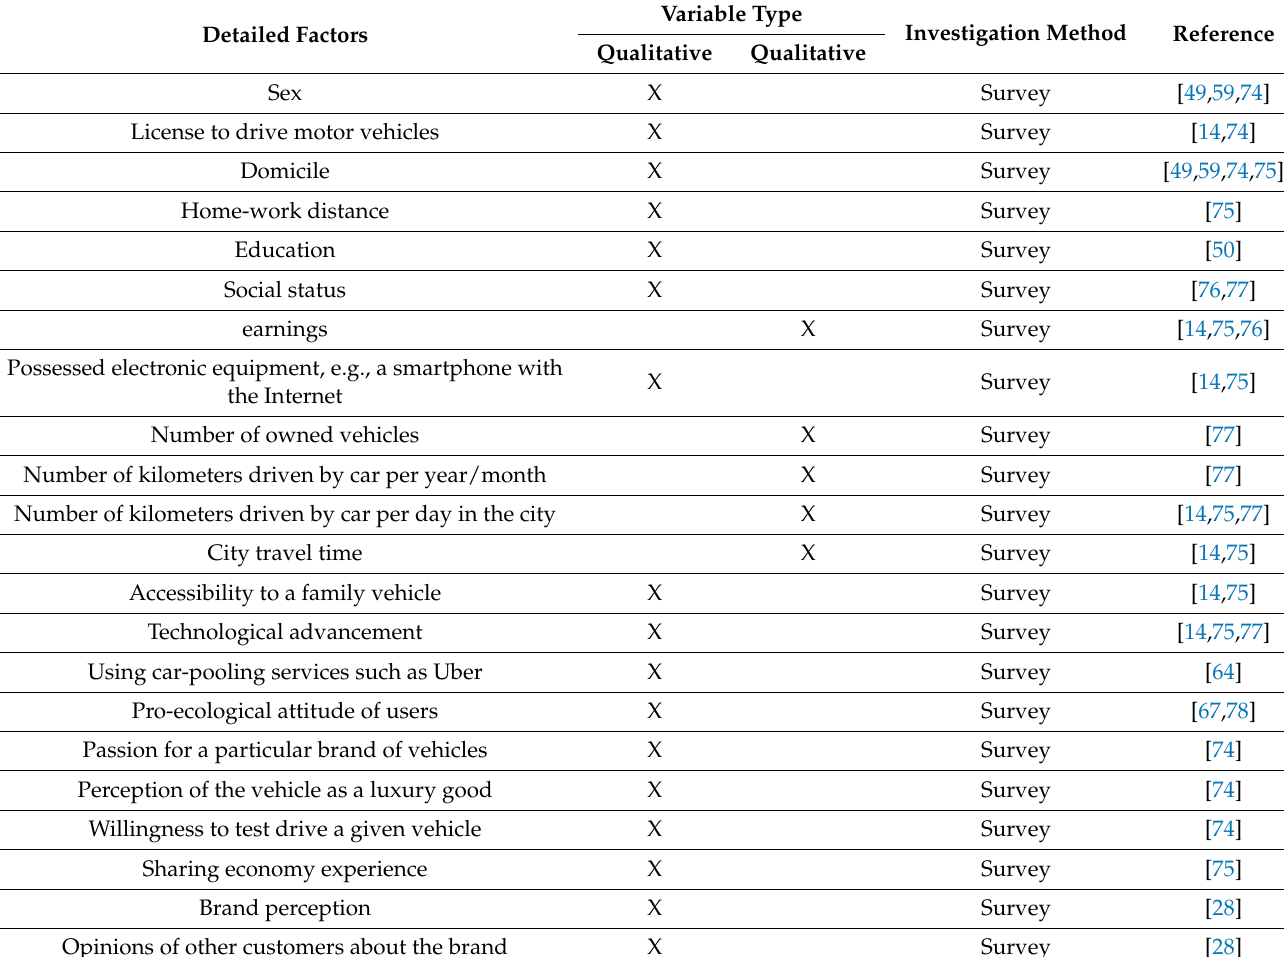
Table 10. Social factors related to current or potential car-sharing